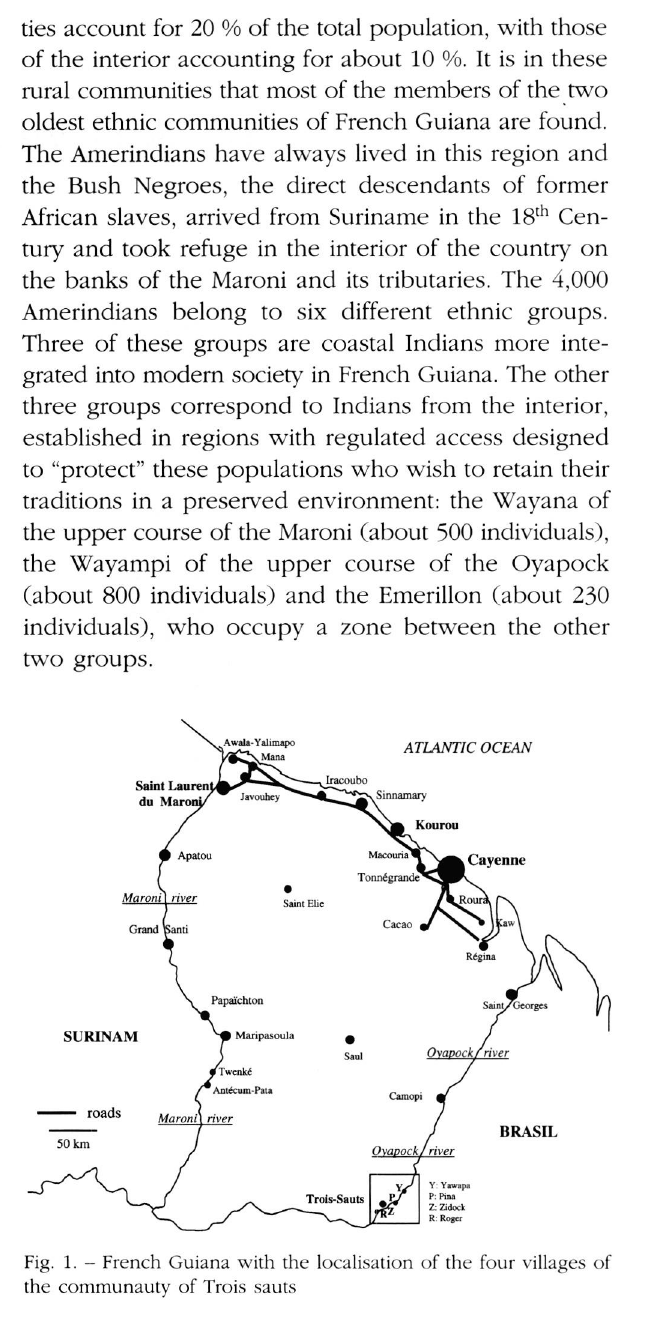
Fig. 1. - French Guiana with the localisation of the four villages of the communauty of Trois sauts